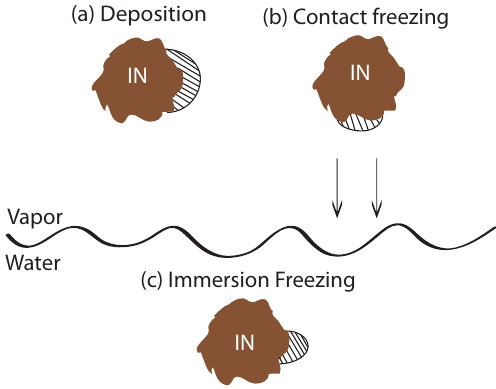
Fig. 3. Illustration of nucleation mechanisms, and the critical em- bryo sizes (shaded areas) required for nucleation (Cooper,